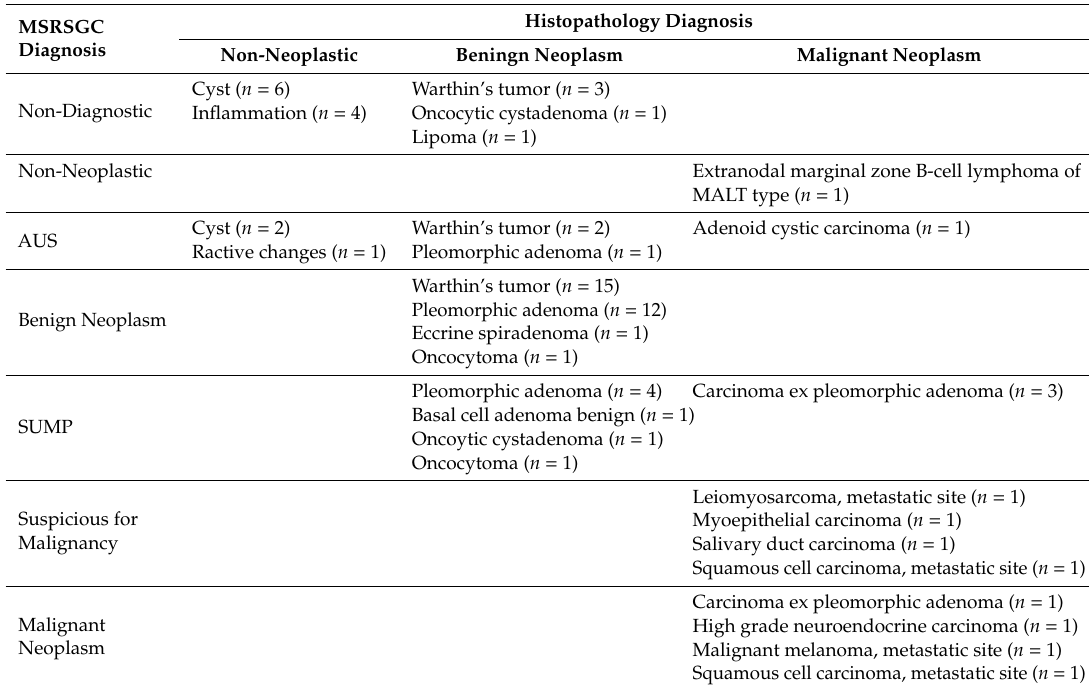
Table 2. Comparison of MSRSGC Diagnoses with Histopathology, Patient